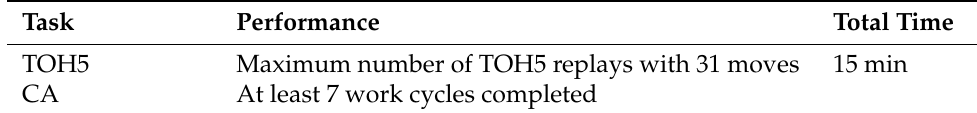
Figure 5. Scenario of the experience. Left, the TOH5 task, the main one, is performed. Right, the CA secondary collaborative assembly task is being developed. Table 3. Experimental